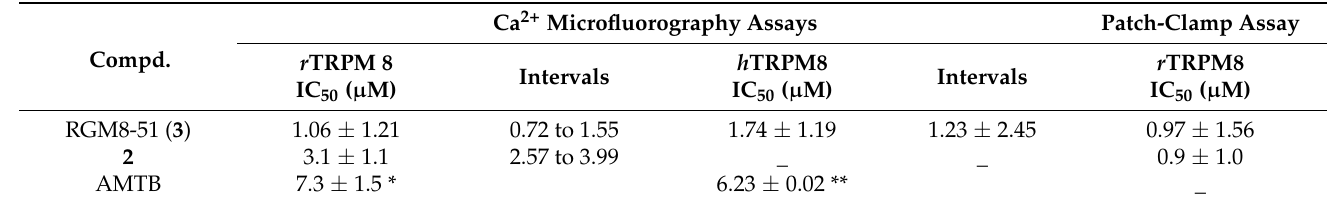
Table 1. Antagonist activity of RGM8-51 at r TRPM8 and h TRPM8 channels (Ca 2+ microfluorography and patch-clamp assays).